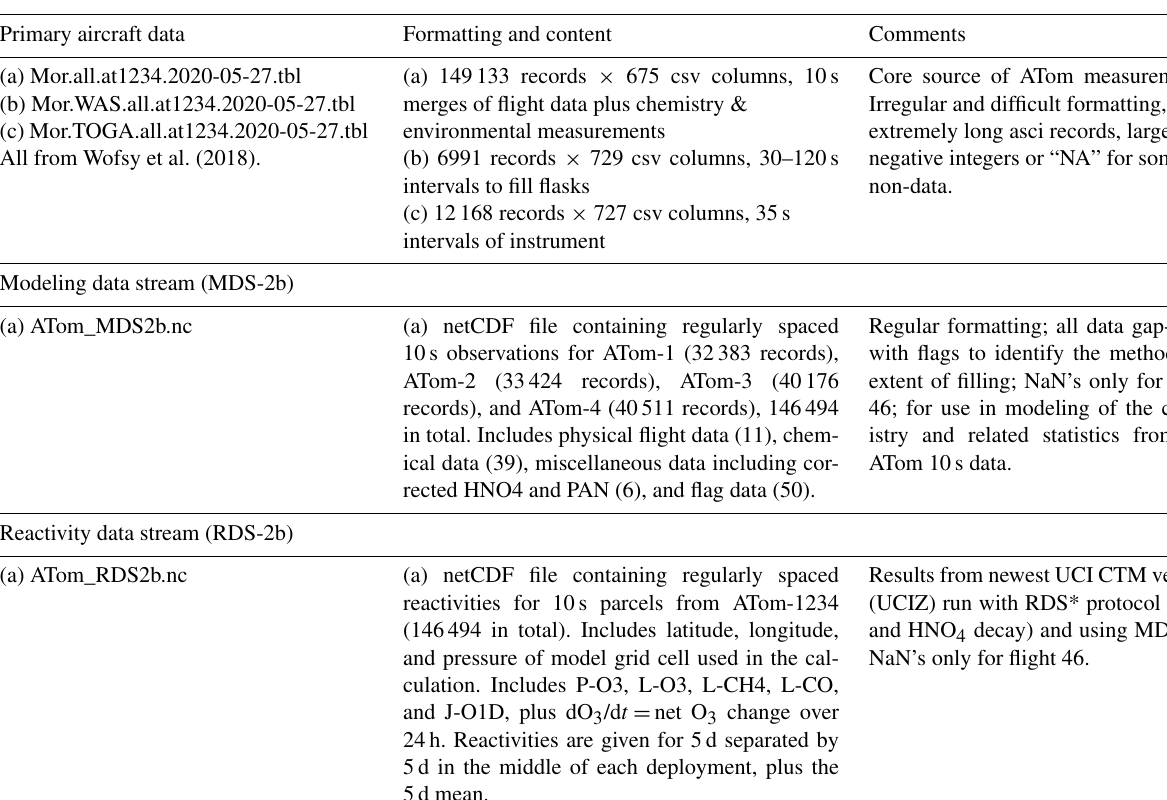
Table 4. ATom data files used